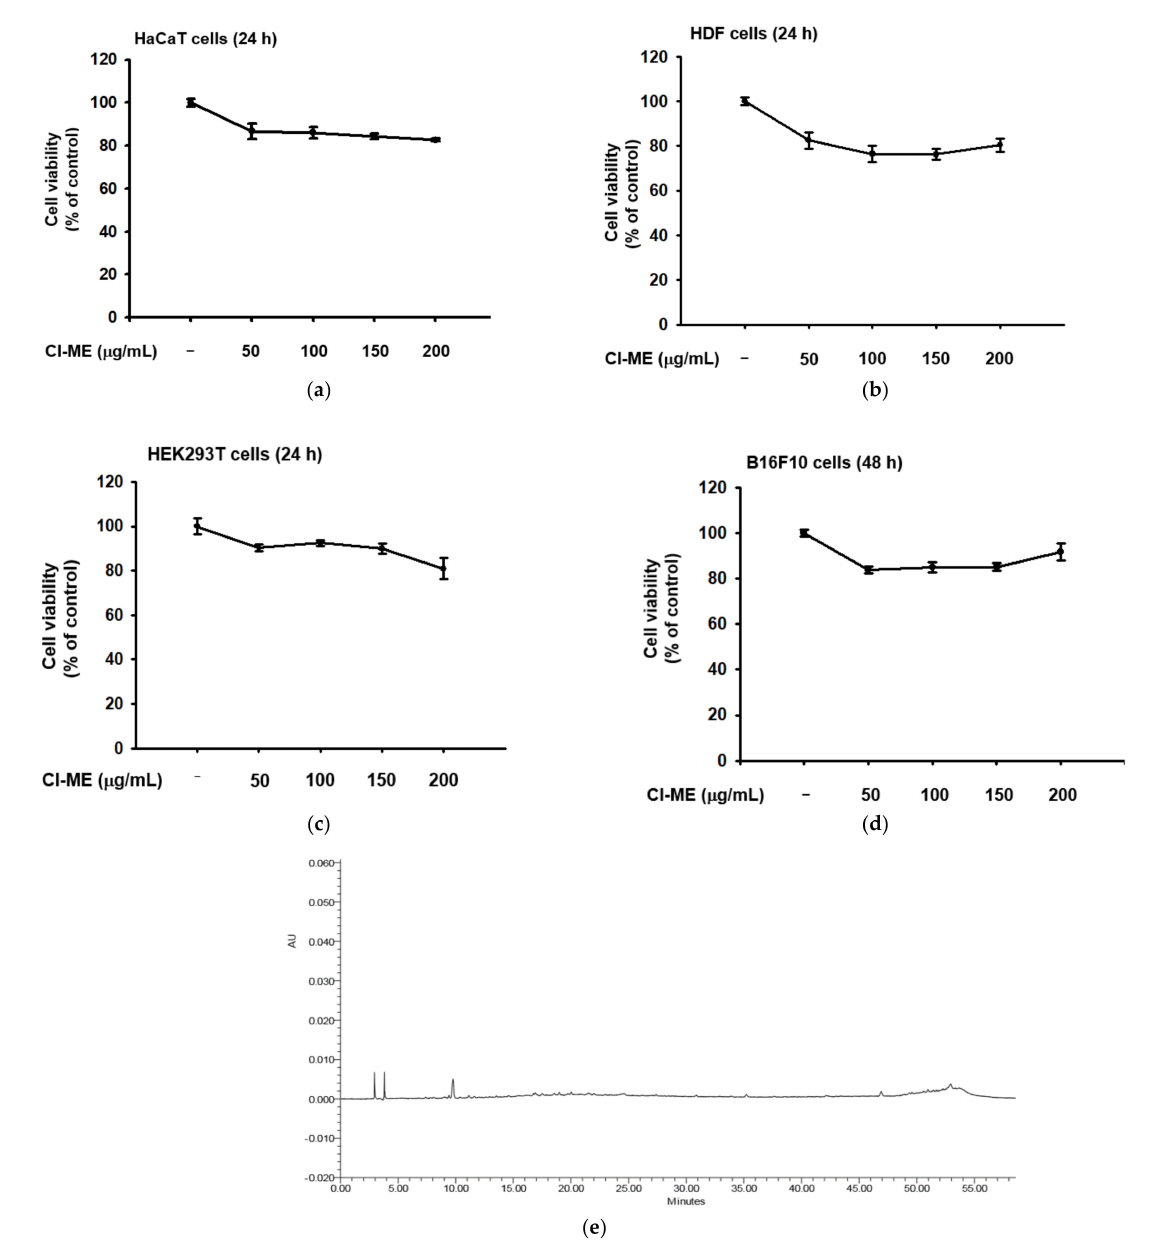
Figure 1. Compound analysis and cytotoxicity of Cl-ME toward HaCaT, HDF, HEK293, and B16F10 cells. ( a ) Viability of HaCaT, ( b ) HDF, ( c ) HEK293T, and ( d ) B16F10 cells after 24 h treatment with Cl-ME (0–200 µ g/mL) was measured using the MTT assay. ( e ) The phytochemical fingerprinting of Cl-ME was observed by